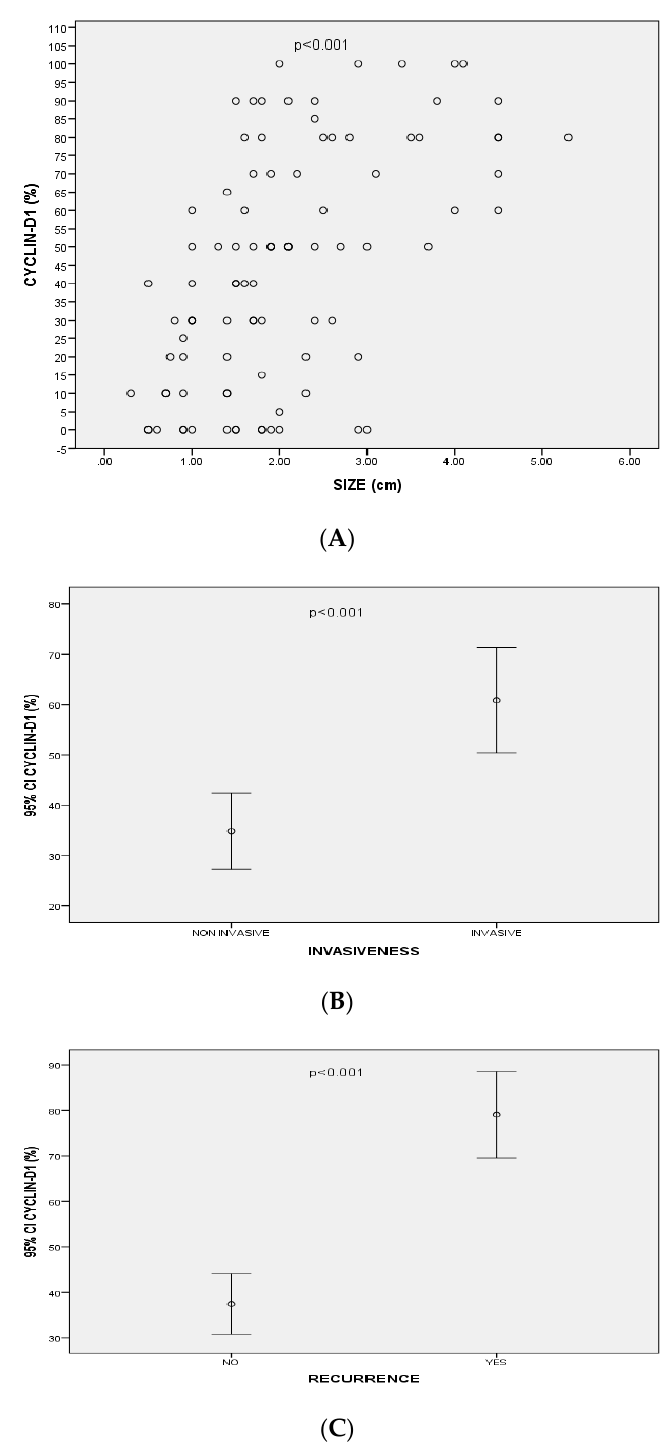
Figure 2. ( A ) Correlation between Cyclin-D1 expression and size of pituitary adenomas ( p < 0.001, r = 0.56); ( B ) Mean values of Cyclin-D1 expression (95% CI) associated with invasiveness of pituitary adenomas; ( C ) Mean values of Cyclin-D1 expression (95% CI) associated with recurrence of pituitary